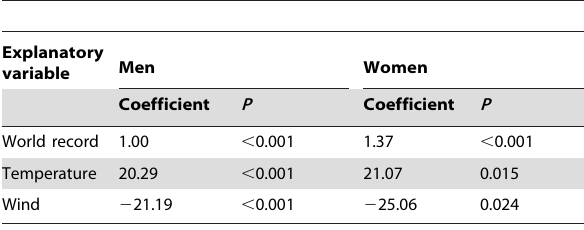
Table 1. Regression results showing effects of temperature and wind on winning times in the Boston